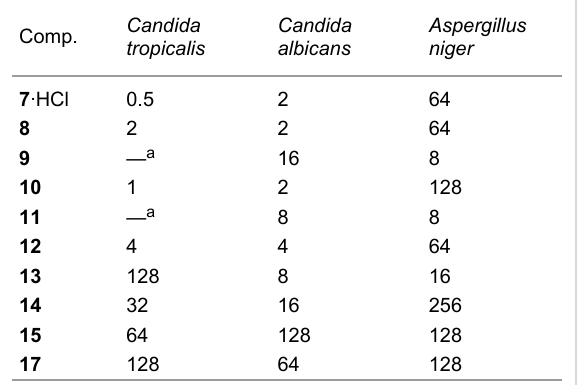
Table 3: Minimum inhibitory concentration (MIC) [ μ g/mL] for 8 – 15 and 17 against human pathogenic fungi.